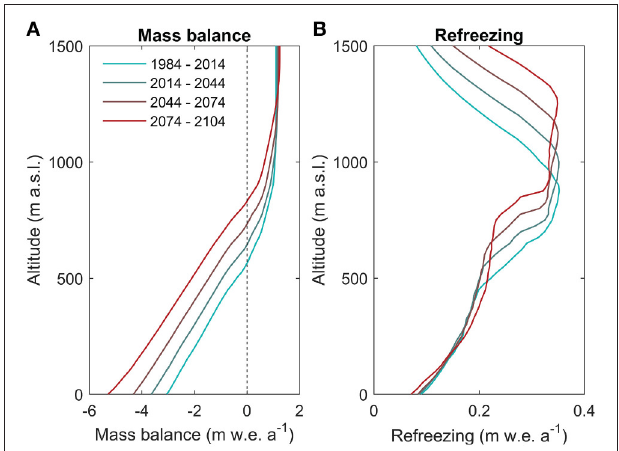
FIGURE 5 | Elevation profiles of the mass balance (A) and refreezing (B) averaged for the periods 1984–2014, 2014–2044, 2044–2074, and 2074–2104. Refreezing in (B) represents total refreezing within the vertical model domain extending down to a depth of